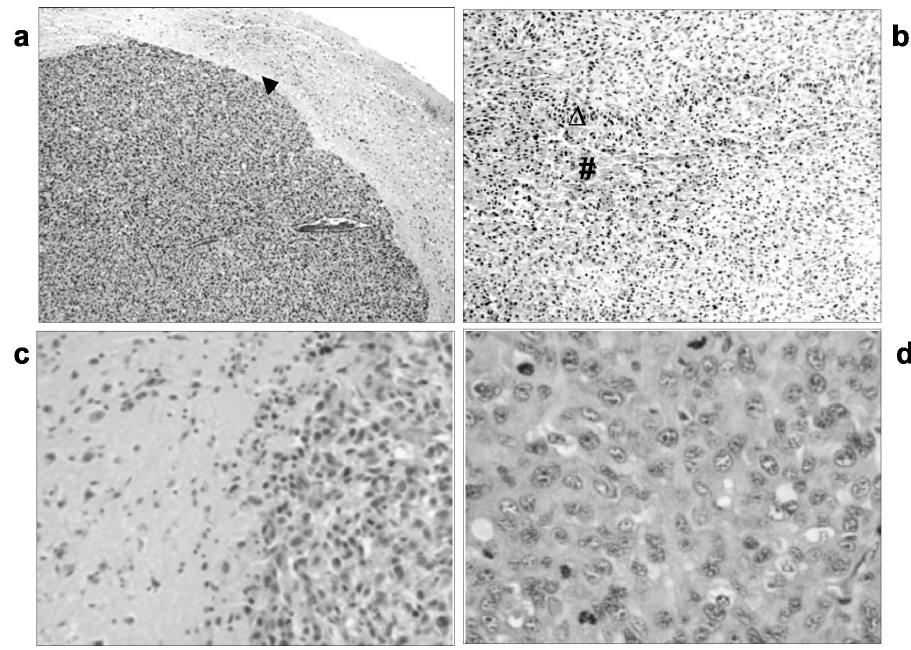
Figure 2 - H&E. Intra-cerebral tumor induced by inoculation of U87MG cells in Provett rats. (a) Brain-tumor interface (  ) with high cellularity and neovascularization, 40x; (b) palisading (  ) cells surrounding a necrotic area (#), 100x; (c) brain tissue (left) and tumoral tissue (right), 200x; (d) mitotic activity,